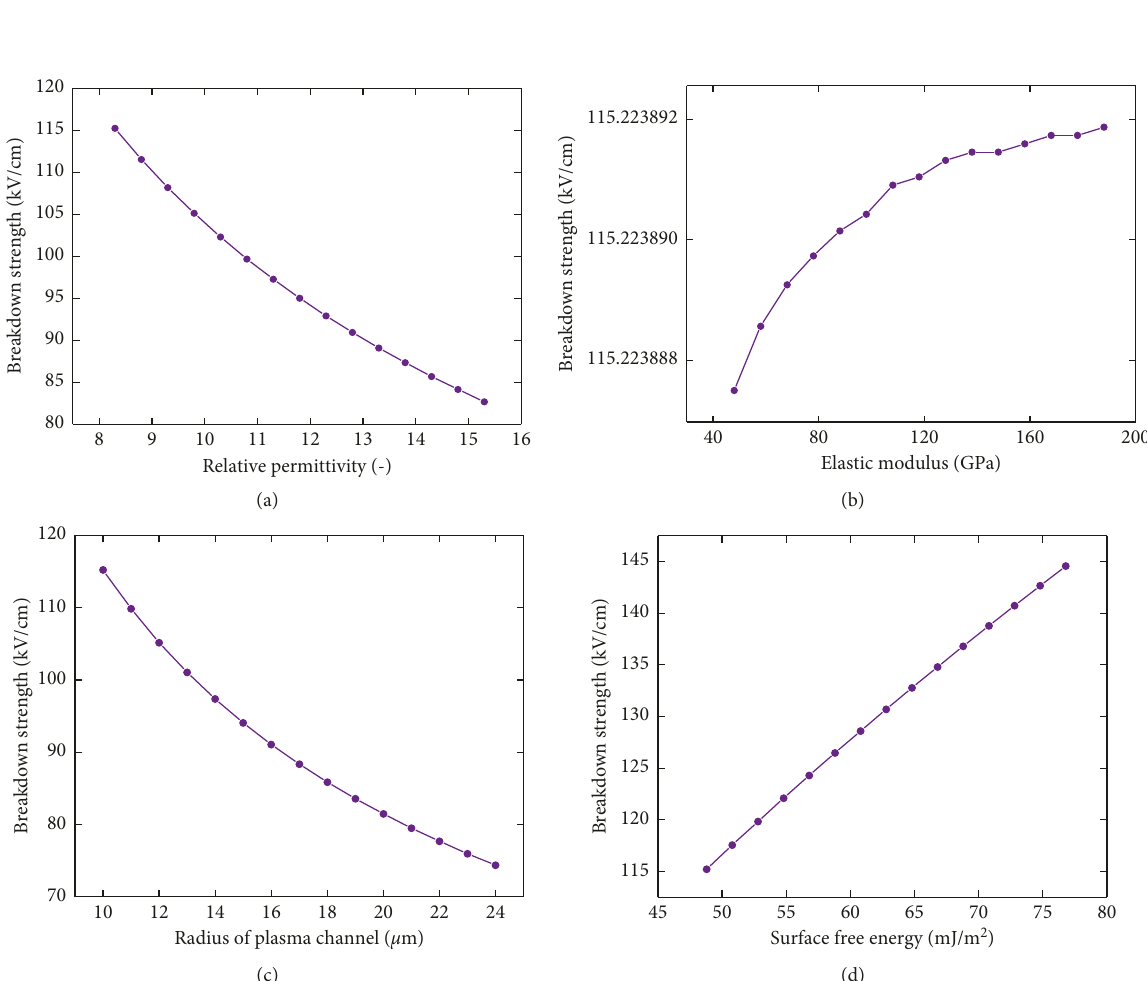
Figure 7: Relationships between electro-breakdown field strength and (a) relative dielectric constant, (b) elastic modulus, (c) plasma channel radius, and (d) surface free energy per unit surface